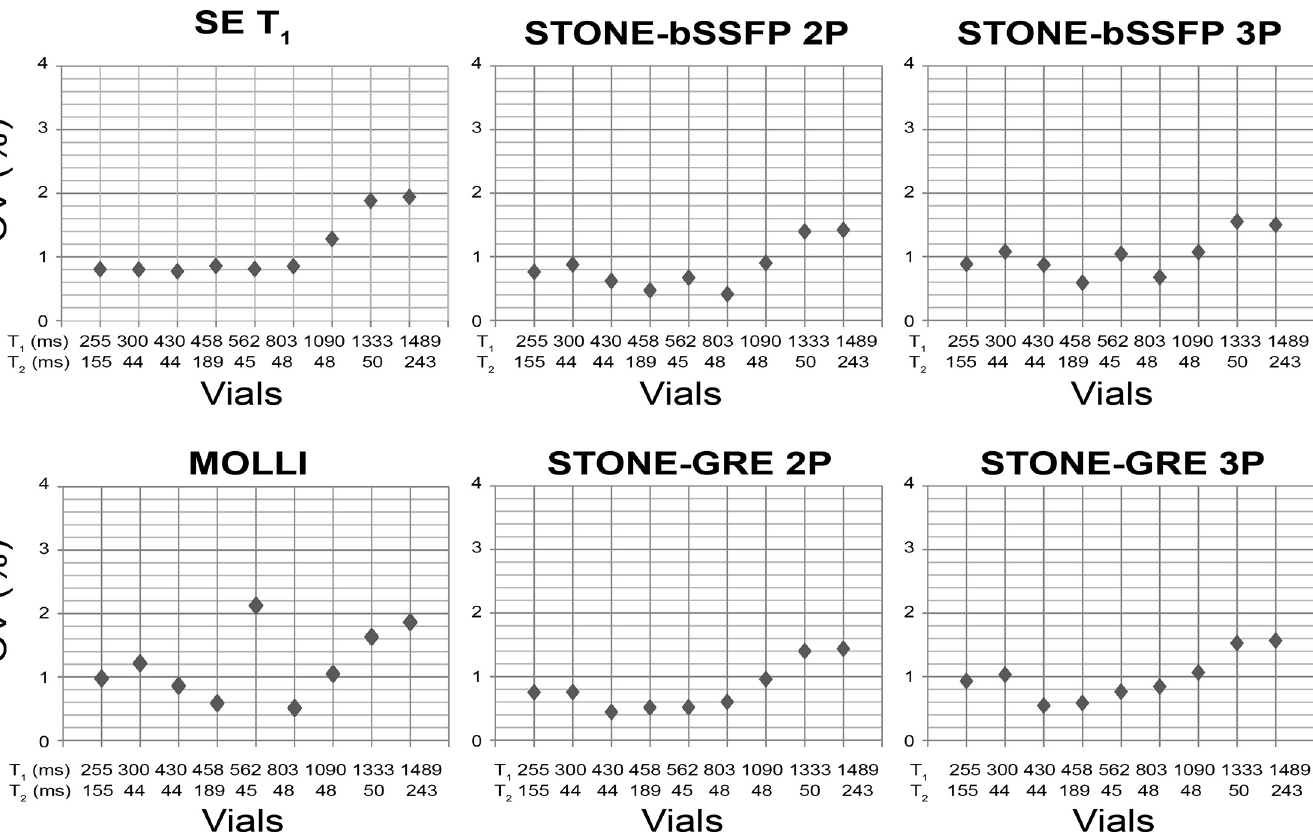
Fig 3. Coefficients of variations (CV) shown as scatter plots for each vial. Vials are sorted from shortest T 1 to longest T 1 time (reference T 1 from the T1MES manual measured by slow inversion-recovery/spin-echo methods at 1.5T: 255, 300, 430, 458, 562, 803, 1090, 1333, and 1489 ms). Vials with higher T 1 time show higher variability.